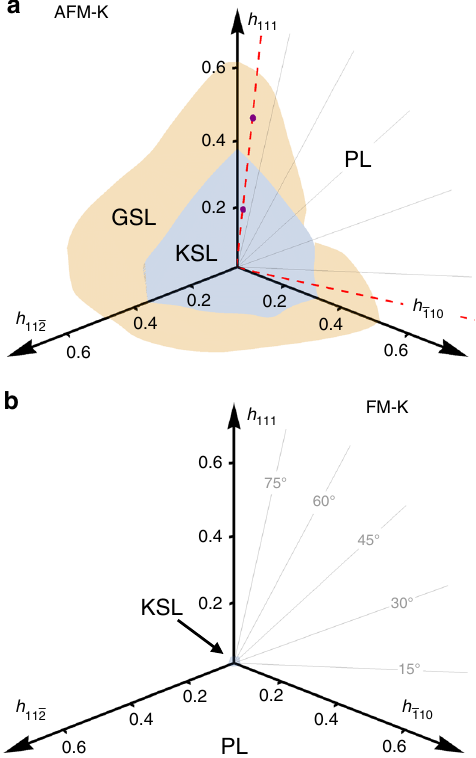
Fig. 1 Phase diagrams in a uniform magnetic fi eld. a The pure AFM Kitaev model and b the pure FM Kitaev model for various tilt angles. For AFM couplings the gapped Kitaev spin liquid (KSL) is surrounded, for a wide range of tilt angles, by a gapless spin liquid (GSL) before giving way to a trivial polarized state (PL). For FM couplings, in contrast, the KSL is found to cover a considerably smaller parameter region with no intermediate GSL (see Supplementary Note 1 for a zoomed-in view of the FM phase diagram). The two (purple) points in ( a ) mark the parameters at which the dynamical structure factor in Fig. 4b, c is